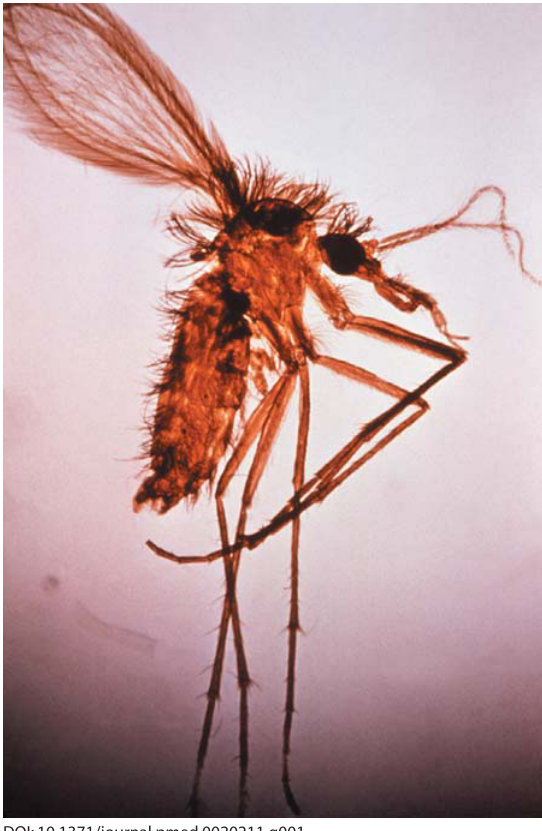
Figure 1. Female Phlebotomus sp. Sandfl y (Photo: